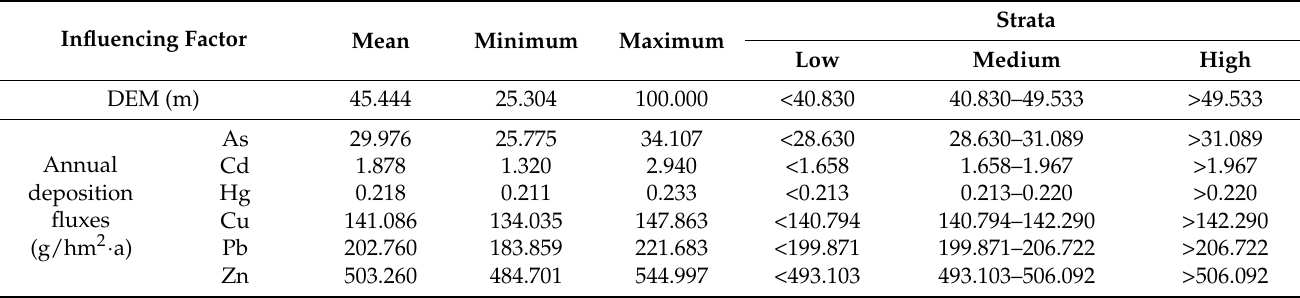
Table 1. The stratification of influencing factors for 329 soil samples.